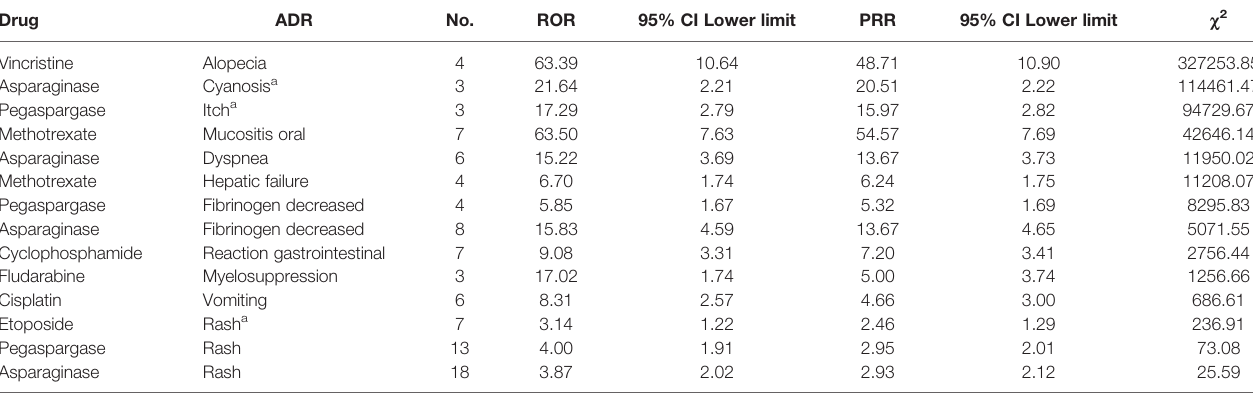
TABLE 5 | Signals of ADRs.